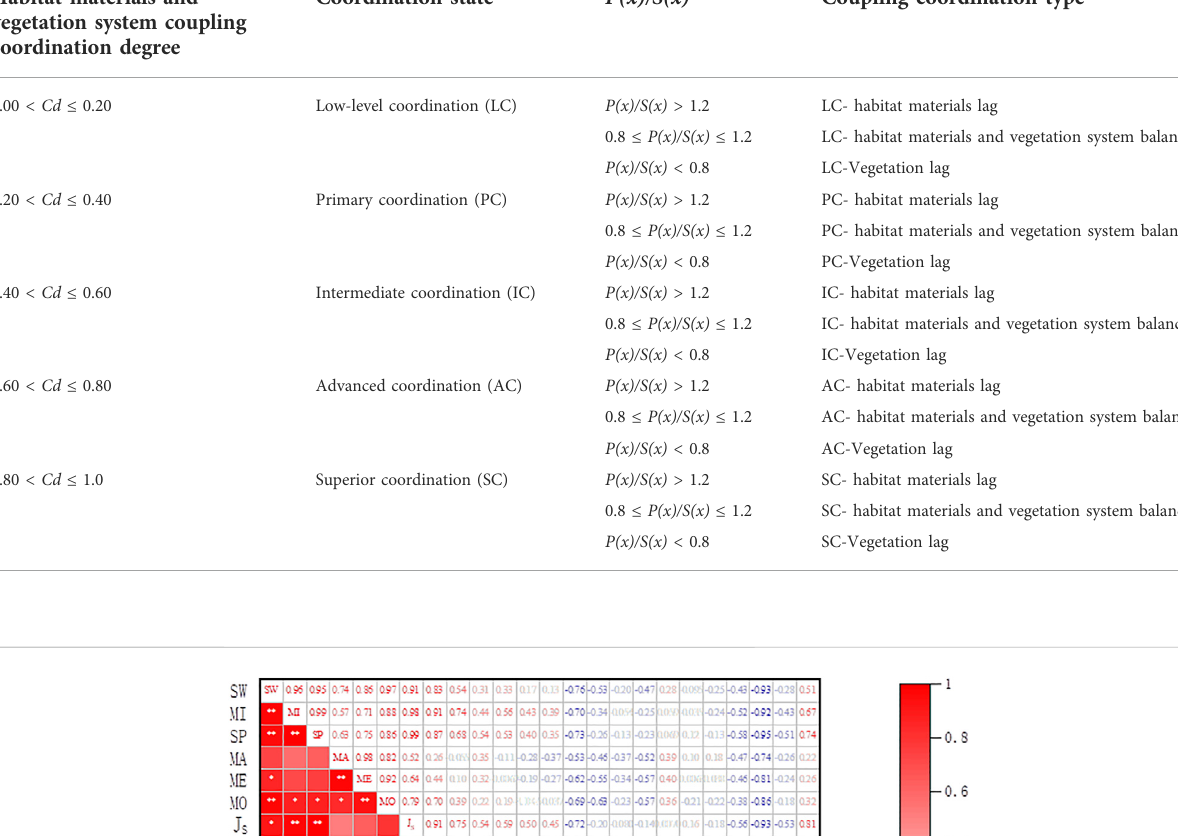
TABLE 3 Classi fi cation of habitat materials and vegetation system coupling coordination types.